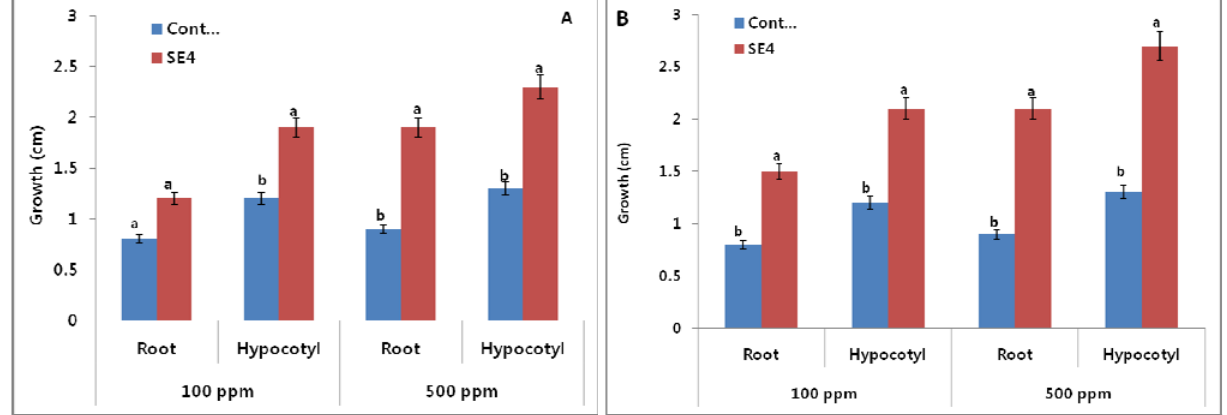
Figure 1. Effect of culture filtrate on the root and hypocotyls of ( A ) lettuce and ( B ) Chinese cabbage seeds using two different concentrations 100 and 500 ppm. SE4 refers to Burkholderia sp. ( n = 10). For each set of treatment, the different letter indicates significant differences ( P < 0.05 ) between SE4 and control treatments as evaluated by Duncan multiple range test. Error bars refers to SE.